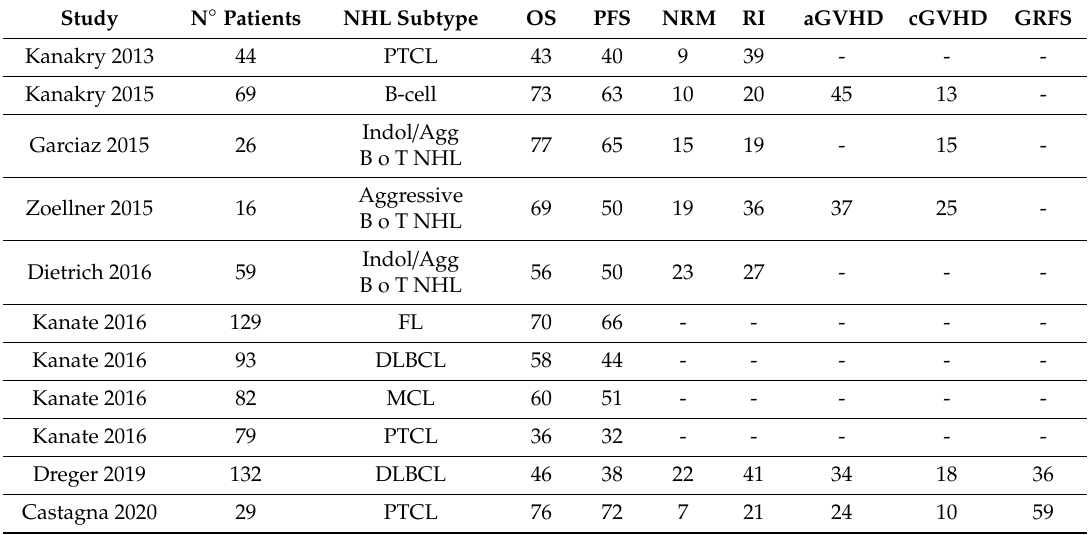
Table legend: OS: overall survival; PFS: progression free survival; NRM: non-relapse mortality; RI: relapse incidence; aGVHD: grade II-IV acute graft-versus-host-disease, cGVHD: chronic graft-versus-host-disease either mild-moderate-severe or moderate-severe according to di ff erent publications; GRFS: GVHD / relapse-free survival; PTCL: peripheral T cell lymphomas, NHL: non-Hodgkin lymphoma, DLBCL. Di ff use large B cell